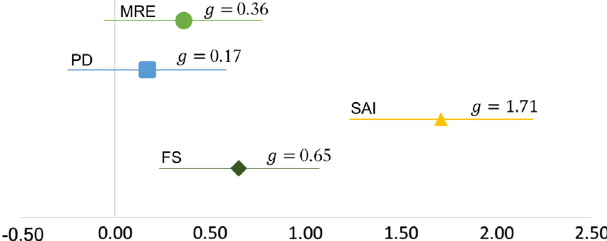
FIG. 2. Hedge ’ s g effect size between the two APSBP affiliated and nonaffiliated programs. The error bars illustrate the 95% confidence intervals. g > 0 indicate higher mean values for APSBP affiliated departments. Any value > 0 . 18 is considered meaningful [51].